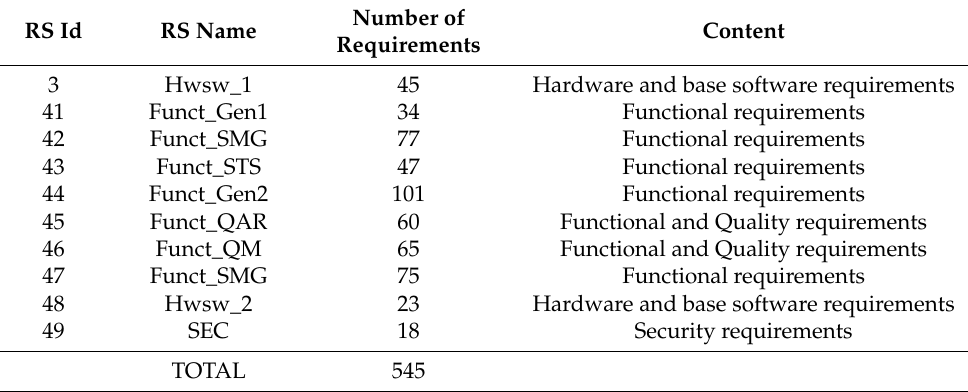
Table 5. Requirements Sets are used as inputs to the